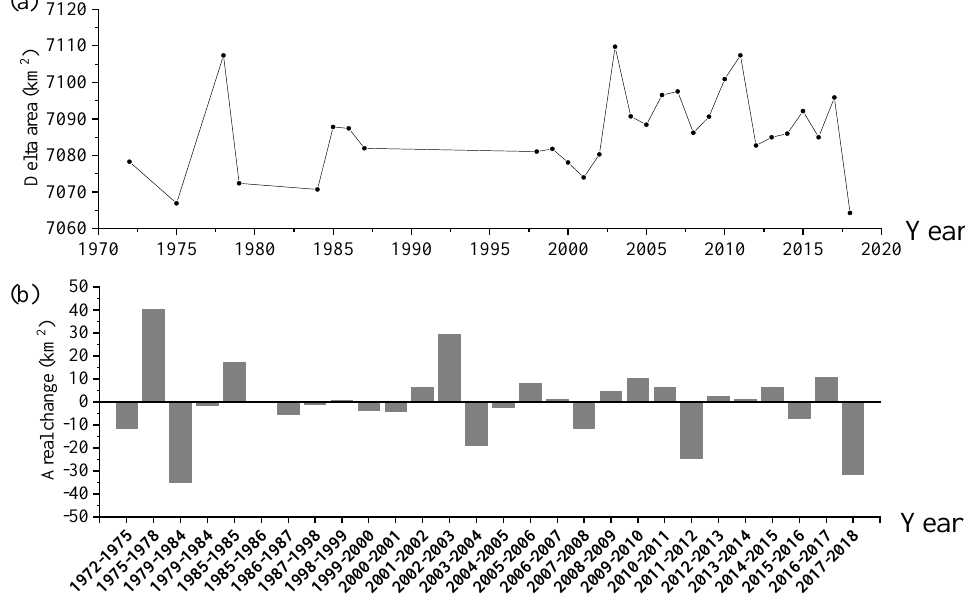
Figure 6. Results of ( a ) delta area and ( b ) progradation-erosion patterns over different periods of the Volta River Delta.